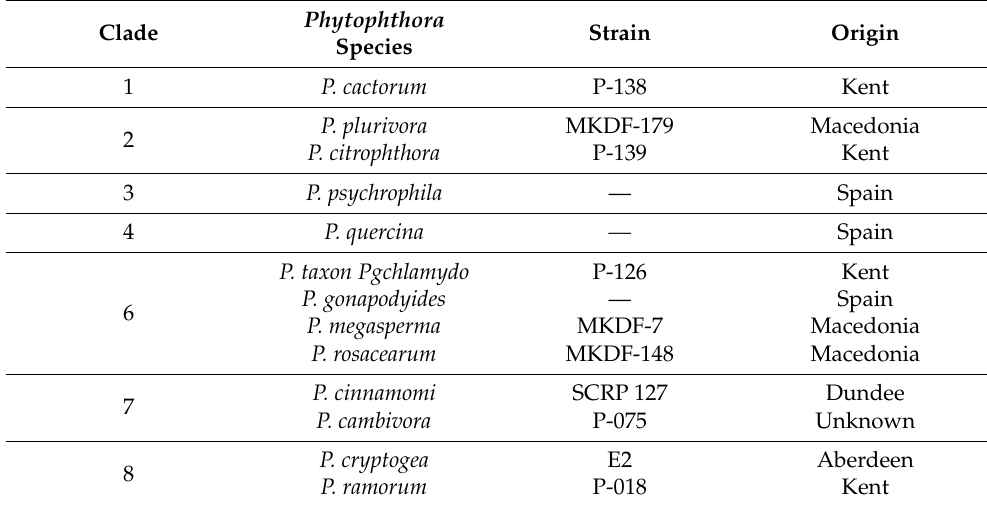
Table 1. Sources of Phytophthora species used in dual culture antagonism tests with A. migulanus . Phytophthora Clade Species 1 P. cactorum P-138 Kent P. plurivora 2 P. citrophthora 3 P. psychrophila — Spain 4 P. quercina — Spain P. taxon Pgchlamydo P-126 6